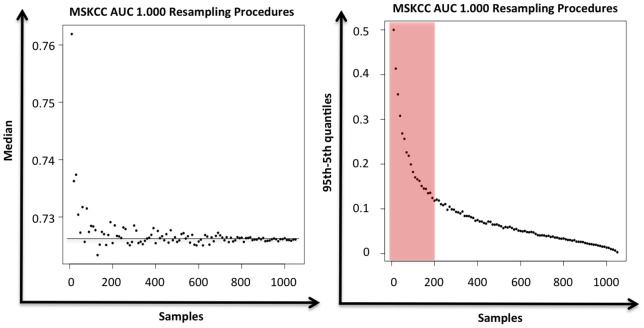
Impact of sample size on the MSKCC nomogram performance.Left: 10.000 resampling procedures of 10 to 1050 (increment series by 10 samples) ER positive HER2 negative breast cancer samples. MSKCC AUC median value for each re-sampling categories. Right: 10.000 resampling procedures of 10 to 1050 (increment series by 10 samples) ER positive HER2 negative breast cancer samples. MSKCC AUC 95th percentile minus MSKCC AUC 5th percentile value for each re-sampling categories.